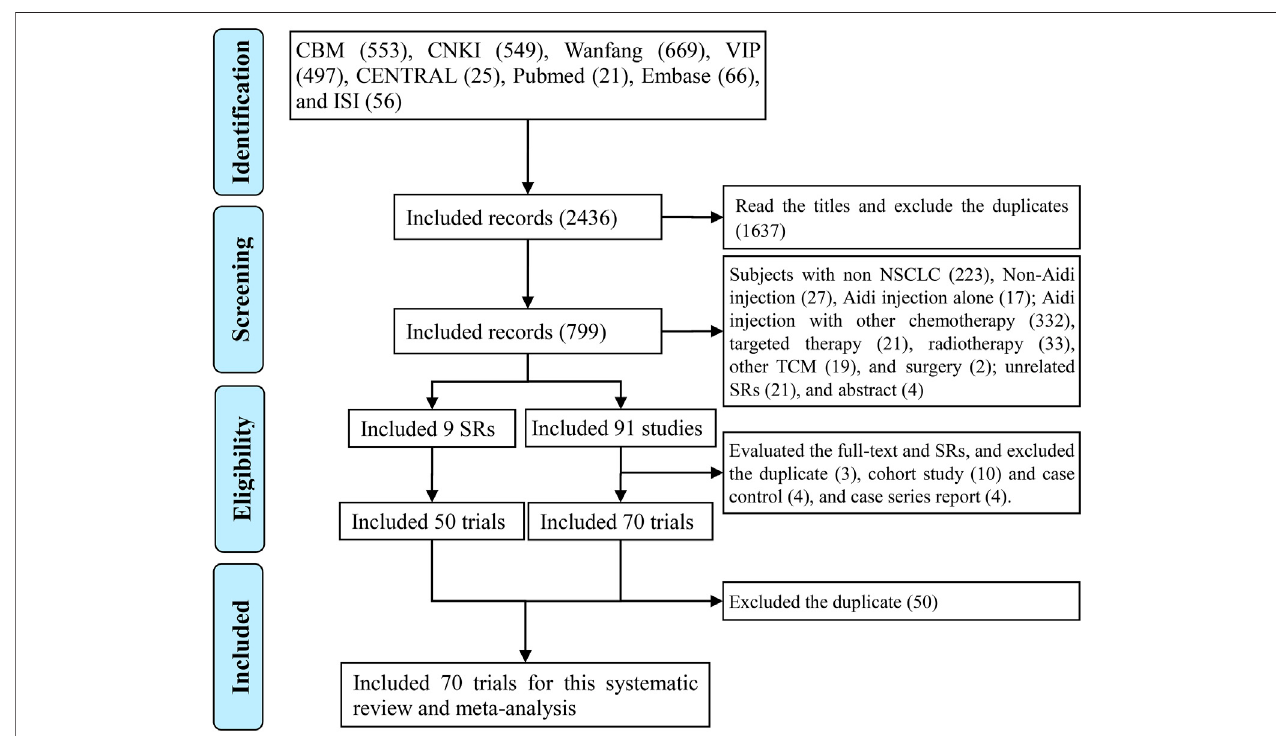
FIGURE 1 | PRISMA 2009 fl ow diagram for the eligible trials We identi fi ed 70 eligible trials for this analysis.